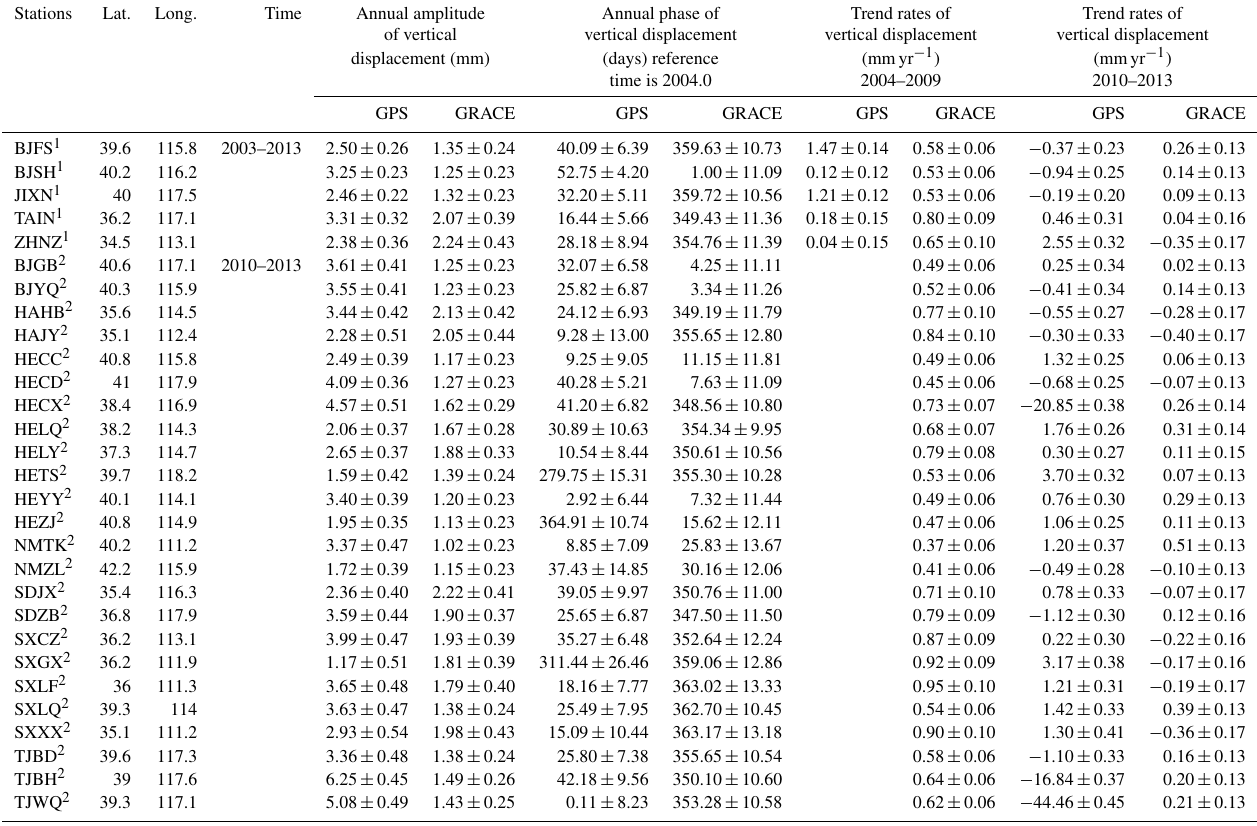
Table 1. GPS station information.